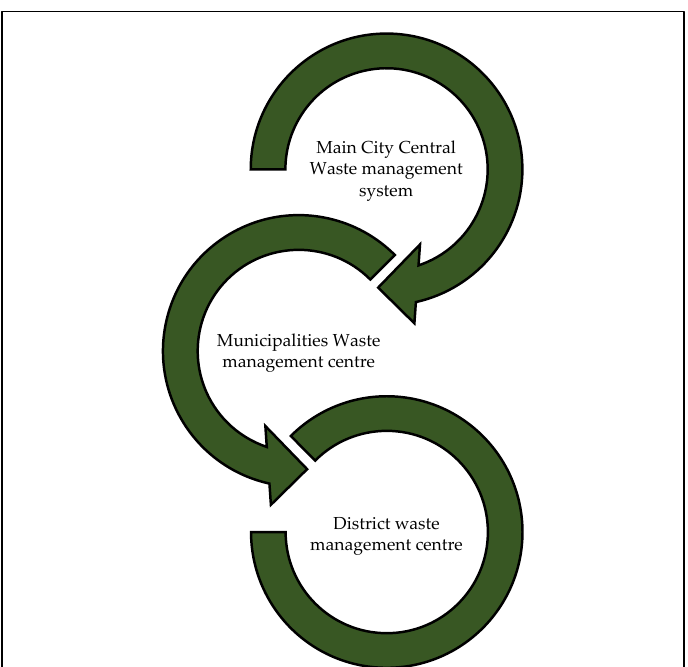
Figure 8. Waste management system administrative centers.